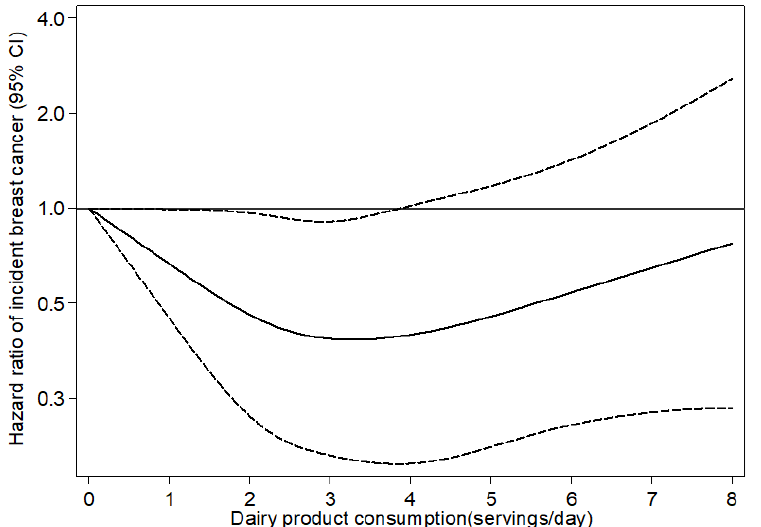
Figure 2. Restricted cubic splines for the hazard ratio (HR) and 95% confidence intervals (CIs) of total intake of total dairy product consumption incidence of breast cancer in the “ Seguimiento Universidad de Navarra ” (SUN) cohort. The black line represents the HR, and the dashed lines represent the 95% CIs. A serving/day value of 0 was the reference value. Adjusted for height, years at university, family history of breast cancer (none, after 45 years, or before 45 years), smoking status (never smoker, former smoker, current smoker), lifetime tobacco exposure (pack-years), physical activity (METs-h/week), TV watch- ing (h/day), alcohol intake (g/day, continuous), BMI (<25, 25 – 30, ≥30), age of menarche (<10 years, 10 – 11 years, 12 – 13 years, ≥14 years),